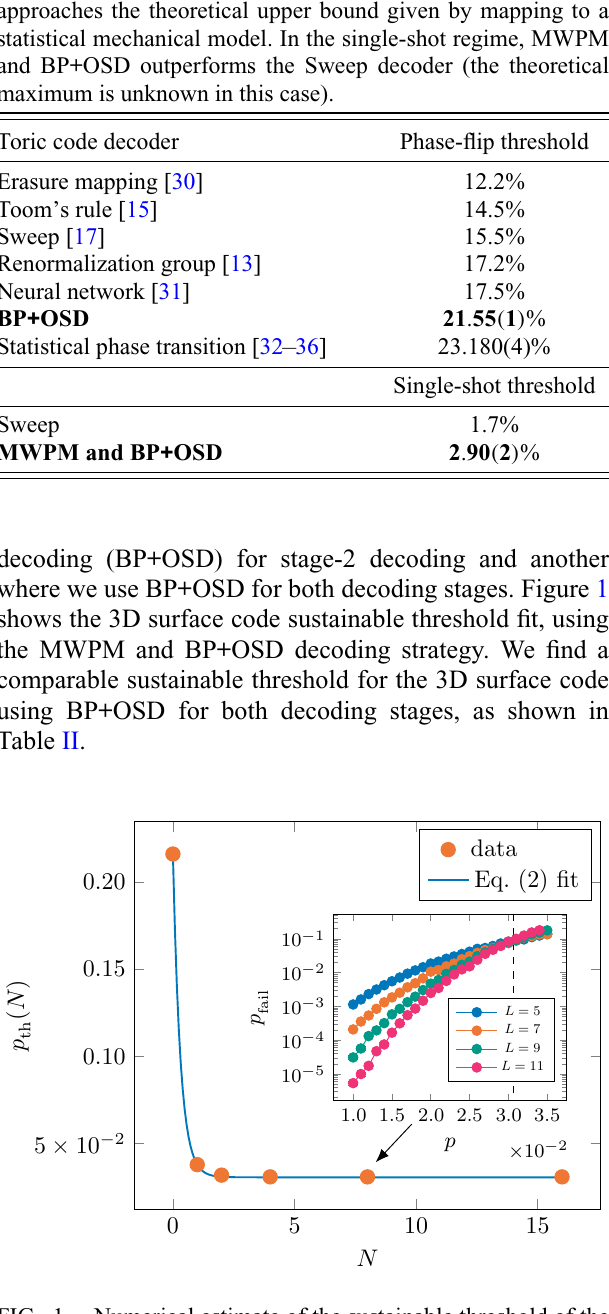
FIG. 1. Numerical estimate of the sustainable threshold of the 3D surface code for a two-stage decoder where we repair the syn- drome using MWPM, and solve the corrected syndrome problem using BP+OSD. We plot the errors threshold p th ( N ) for different numbers of cycles, N . Using the ansatz in Eq. (2), we estimate the sustainable threshold to be p sus = 0.0308 ( 4 ) with γ = 3.23. The inset shows a plot of the logical error rate, p fail , against the phase-flip and measurement error rate, p , for N = 8. The error threshold p th ( 8 ) is the point at which the curves intersect ( L is the code distance).